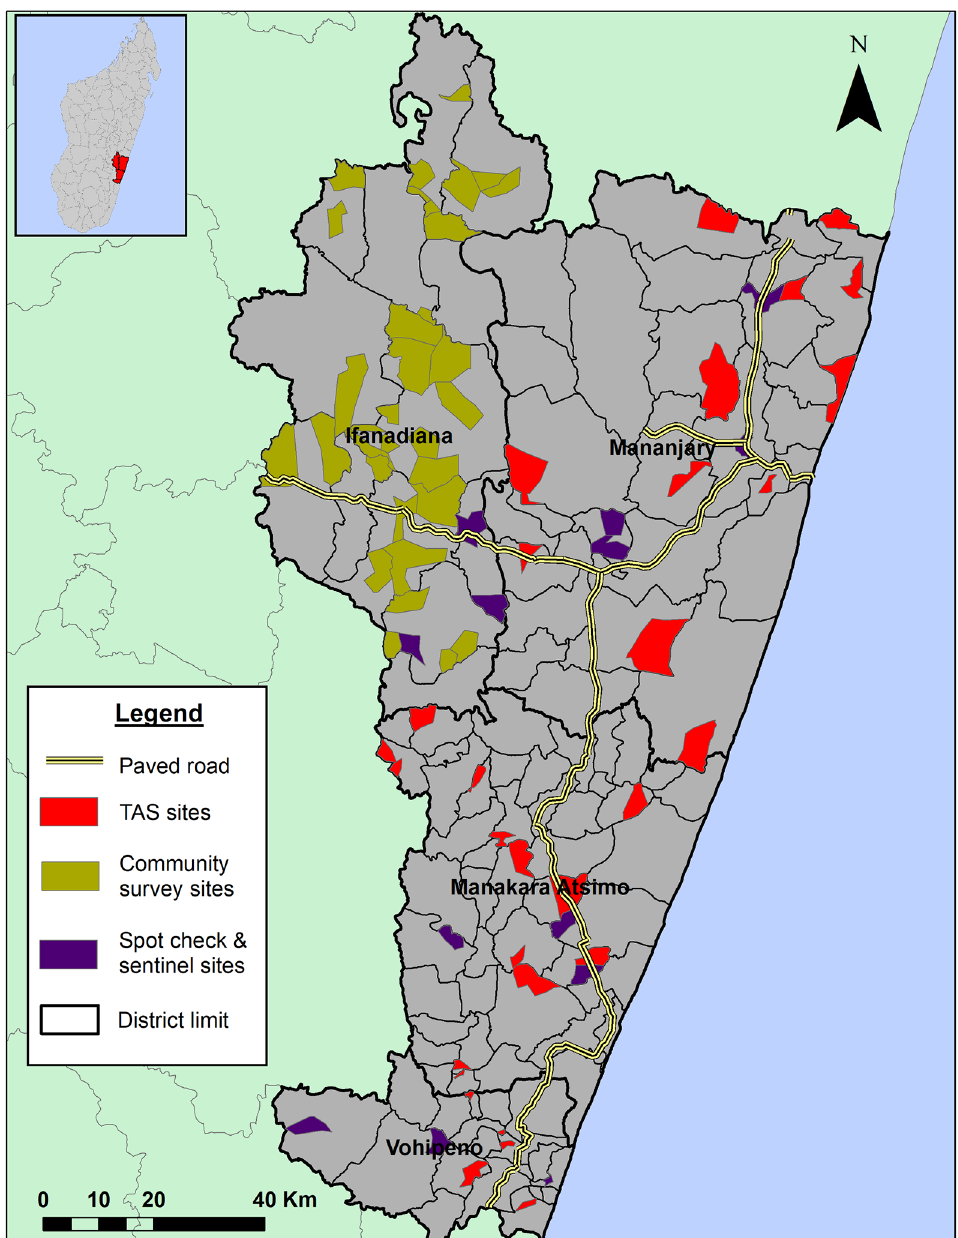
Fig 3. Sampling locations of the three different lymphatic filariasis prevalence surveys that took place in the region of Vatovavy Fitovinany, November-December 2016. Map was created by the authors with ArcMap software, version 10.4.1 using administrative layers from the Government of Madagascar and GPS information from the prevalence